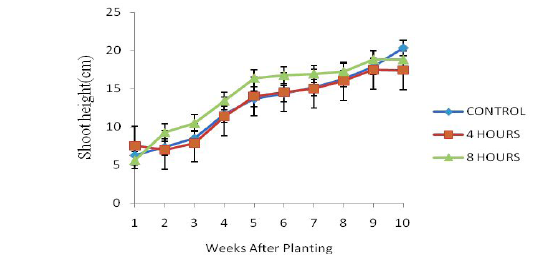
Fig. 1. Effect of prior heat stress on the shoot height of C. pa-